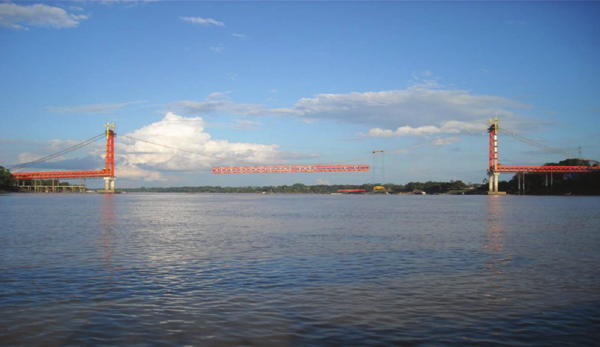
Fig. 9. Type locality of Sternarchella patriciae on the Río Madre de Dios, in front of Puerto Maldonado (Tambopata Department) near the confluence of the Tambopata River. Specimens were collected at about 10 m depth using a 12 foot shrimp